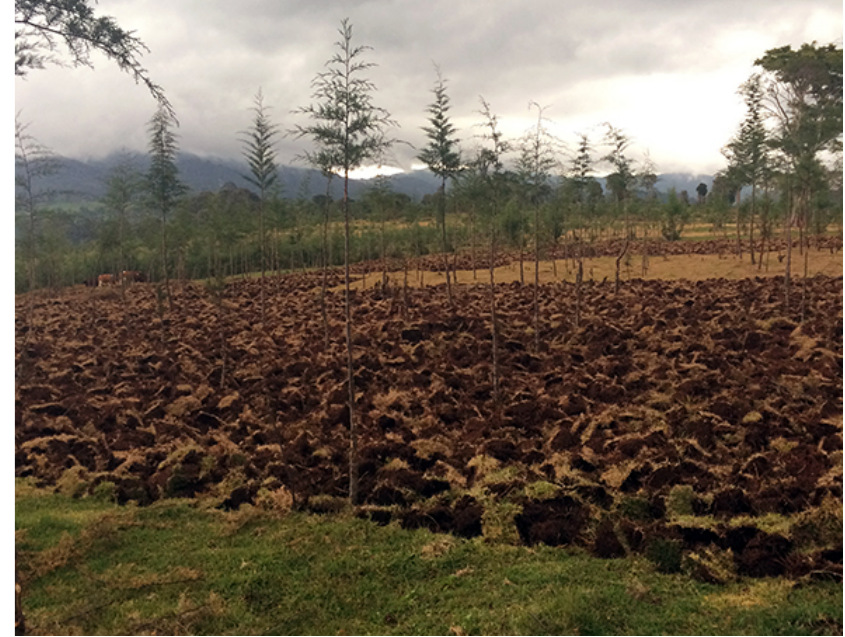
Figure 12. Reforestation programme in the Chemorgok Forest Block (Photo: Donald Kipruto Kimutai, 18 July 2015).